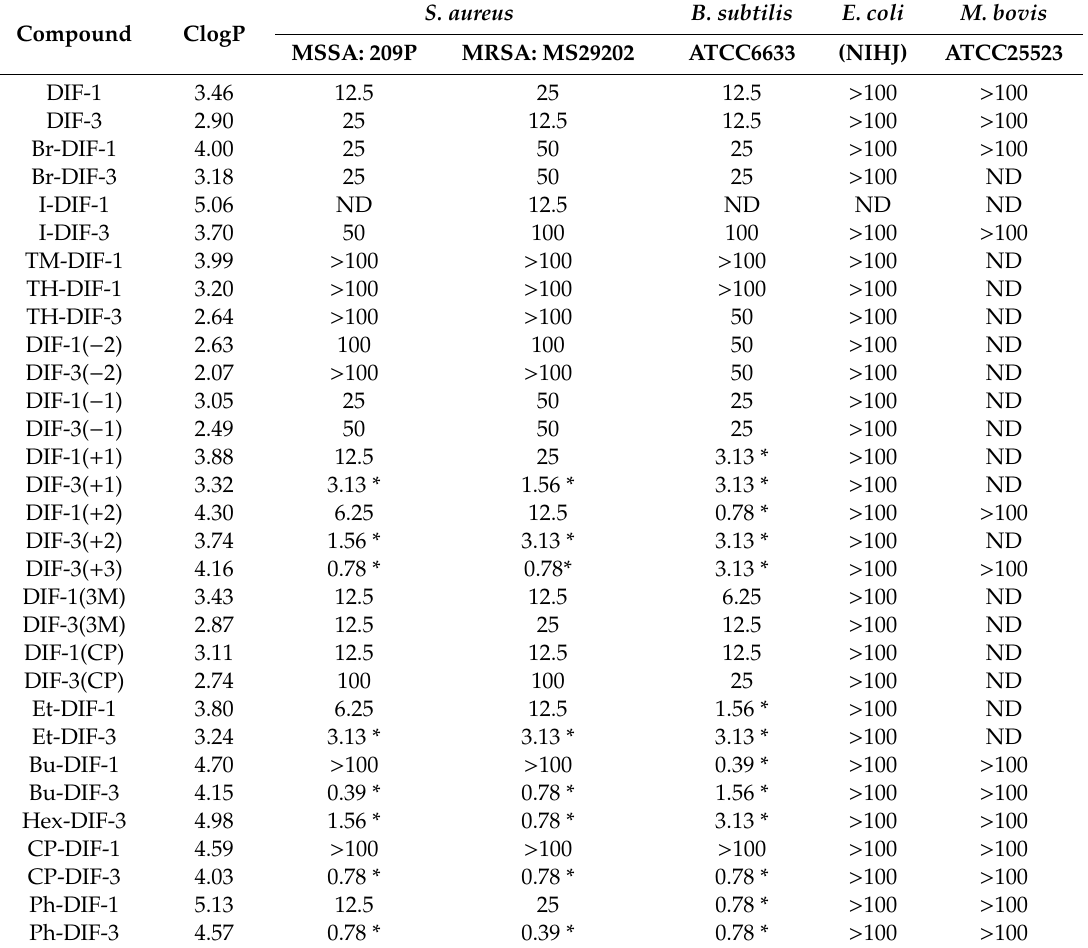
Table 1. ClogP and minimum inhibitory concentration (MIC) ( µ M) values of DIFs and DIF derivatives against MSSA, MRSA, Bacillus subtilis , Escherichia coli, and Mycobacterium bovis .